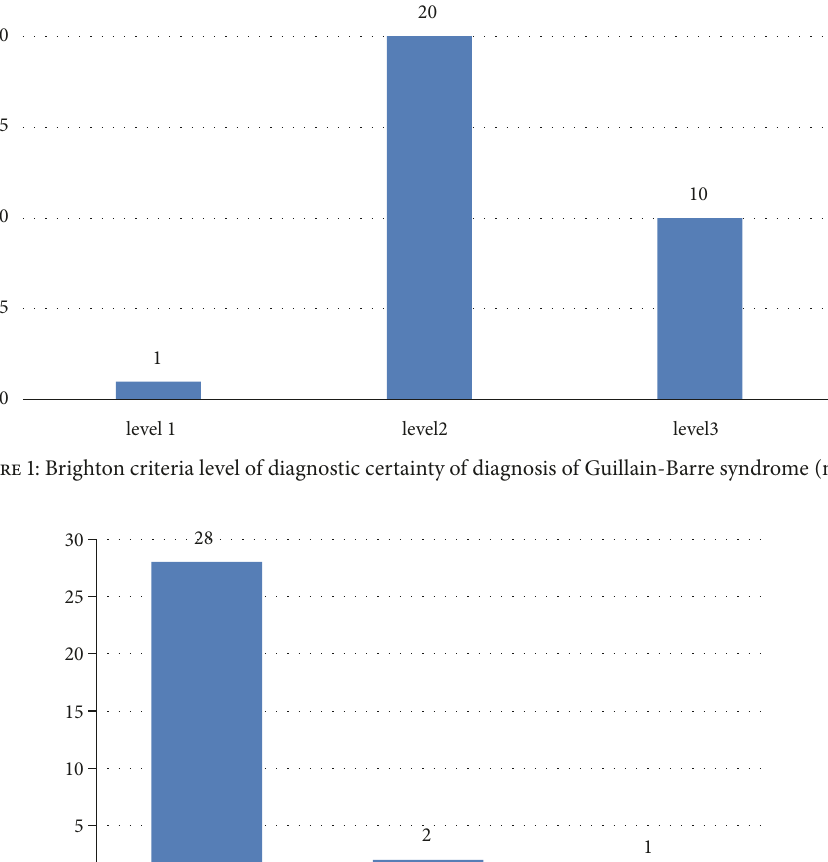
were sensory symptoms (22.6%), respiratory failure